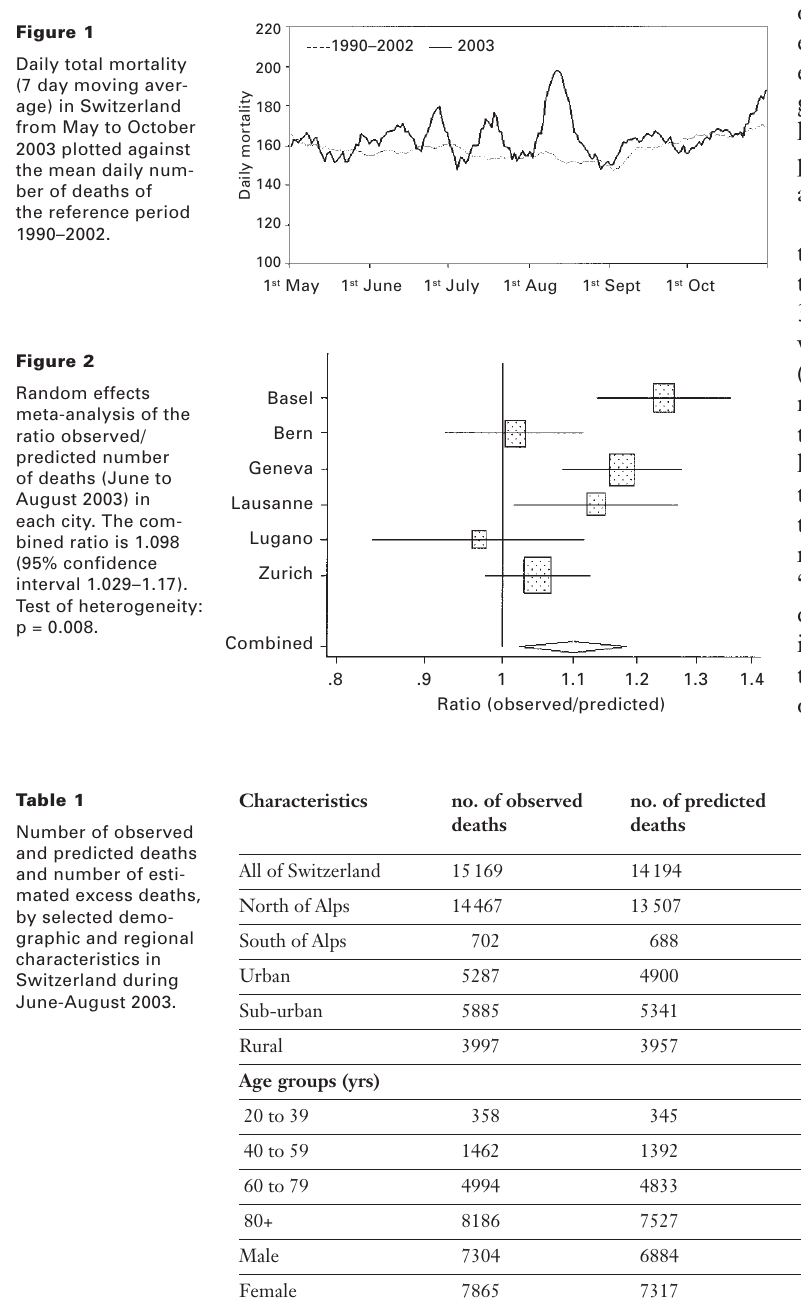
Table 1 Number of observed and predicted deaths and number of esti- mated excess deaths, by selected demo- graphic and regional characteristics in Switzerland during